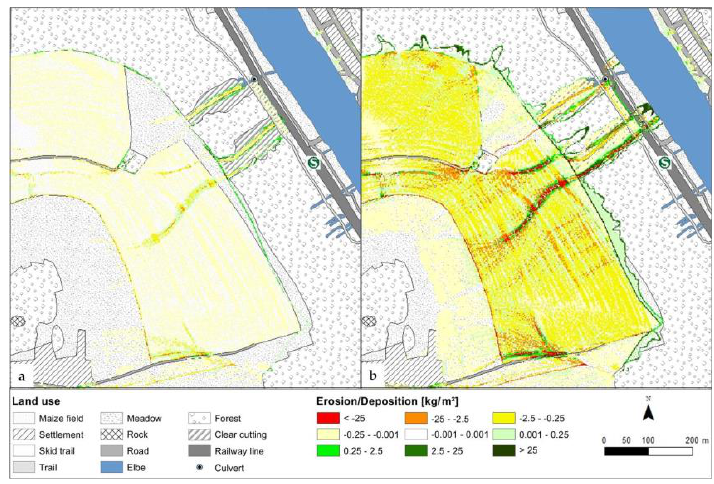
Figure 12. The erosion risk map with ( a ) RY- and ( b ) RZ-product for 31 May 2016.